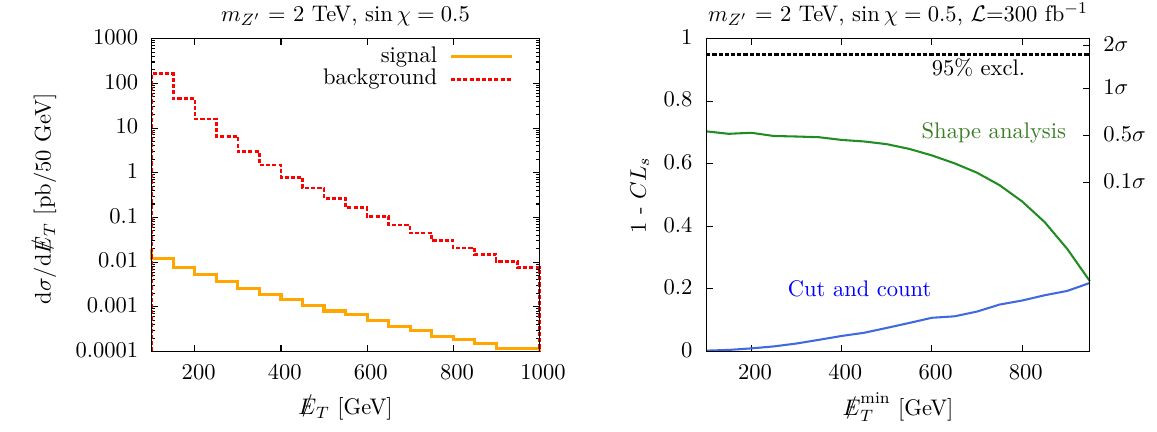
Figure 9: Left: / E distribution for a typical signal and the combined W / Z + jets back- T ground. Right: expected confidence limit and associated Gaussian significance as a function of the / E cut using the full / E shape information (green) versus a cut-and- T T count results